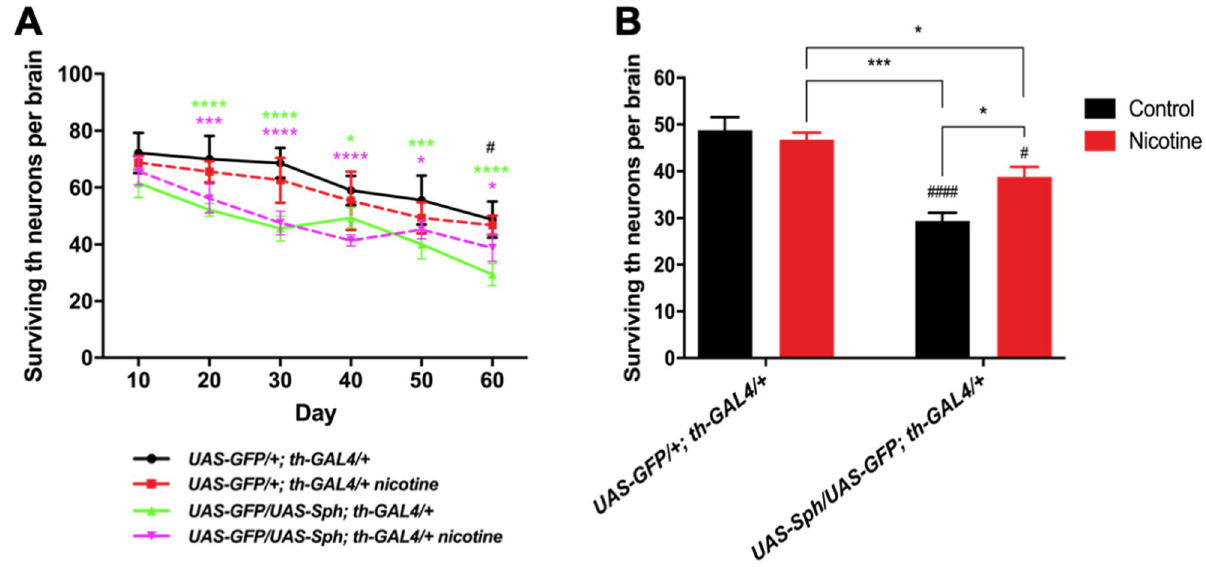
Figure 5. Nicotine promotes dopaminergic neuron survival. A) Dopaminergic neuron loss over time in control (UAS-GFP / +; th-GAL4/+) and experimental ( UAS-GFP/UAS-Sph; th-GAL4/ +) genotypes; untreated populations are represented by solid lines and treated populations by dotted lines. No significant differences were evidenced between the treated and untreated control genotype. Flies expressing Sph-1 in dopaminergic neurons have significantly fewer neurons than the control genotype throughout their life. However this difference becomes smaller between control and the Sph- expressing treated population as flies age. B) The number of surviving TH neurons in each experimental condition at the last time point studied (Day 60) evidences a reduction in th-positive neurons in the Sph-1 expressing flies compared with control genotype (#### p < 0.0001). Interestingly, this analysis also shows that nicotine treatment does not affect the number of th-positive neurons in the control genotype (p > 0.05), but it does so in the Sph-1 expressing flies (# p < 0.05 compared with the control genotype not treated with nicotine). The Sph-1 expressing flies treated with nicotine show a partial recovery in the number of th-positive neurons, since it is significantly increased compared